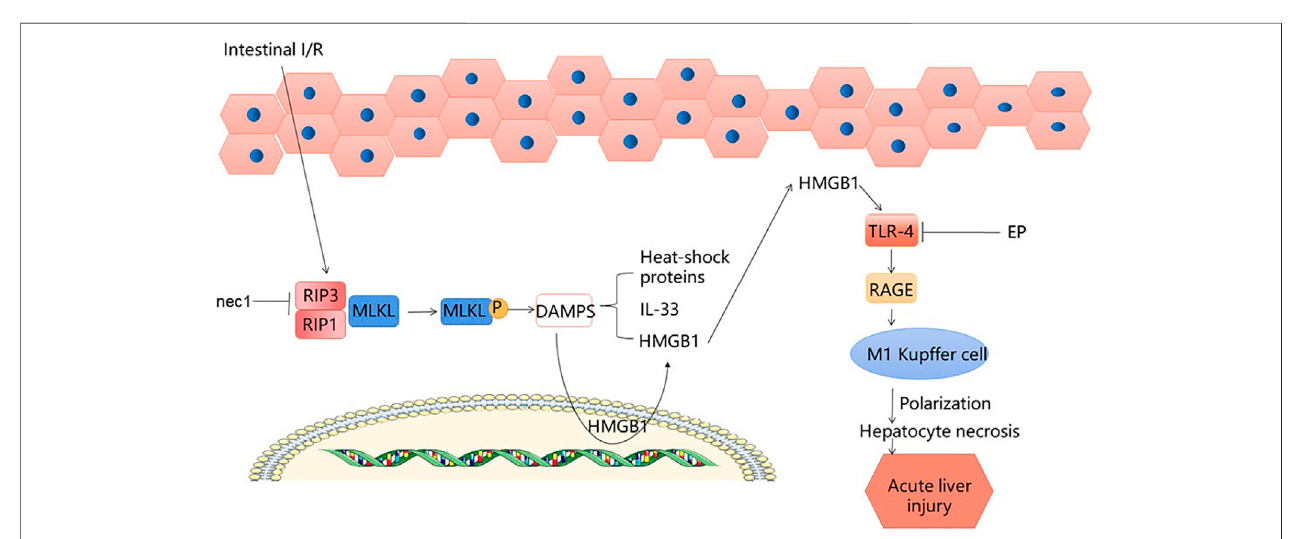
FIGURE 3 | HMGB1 signaling